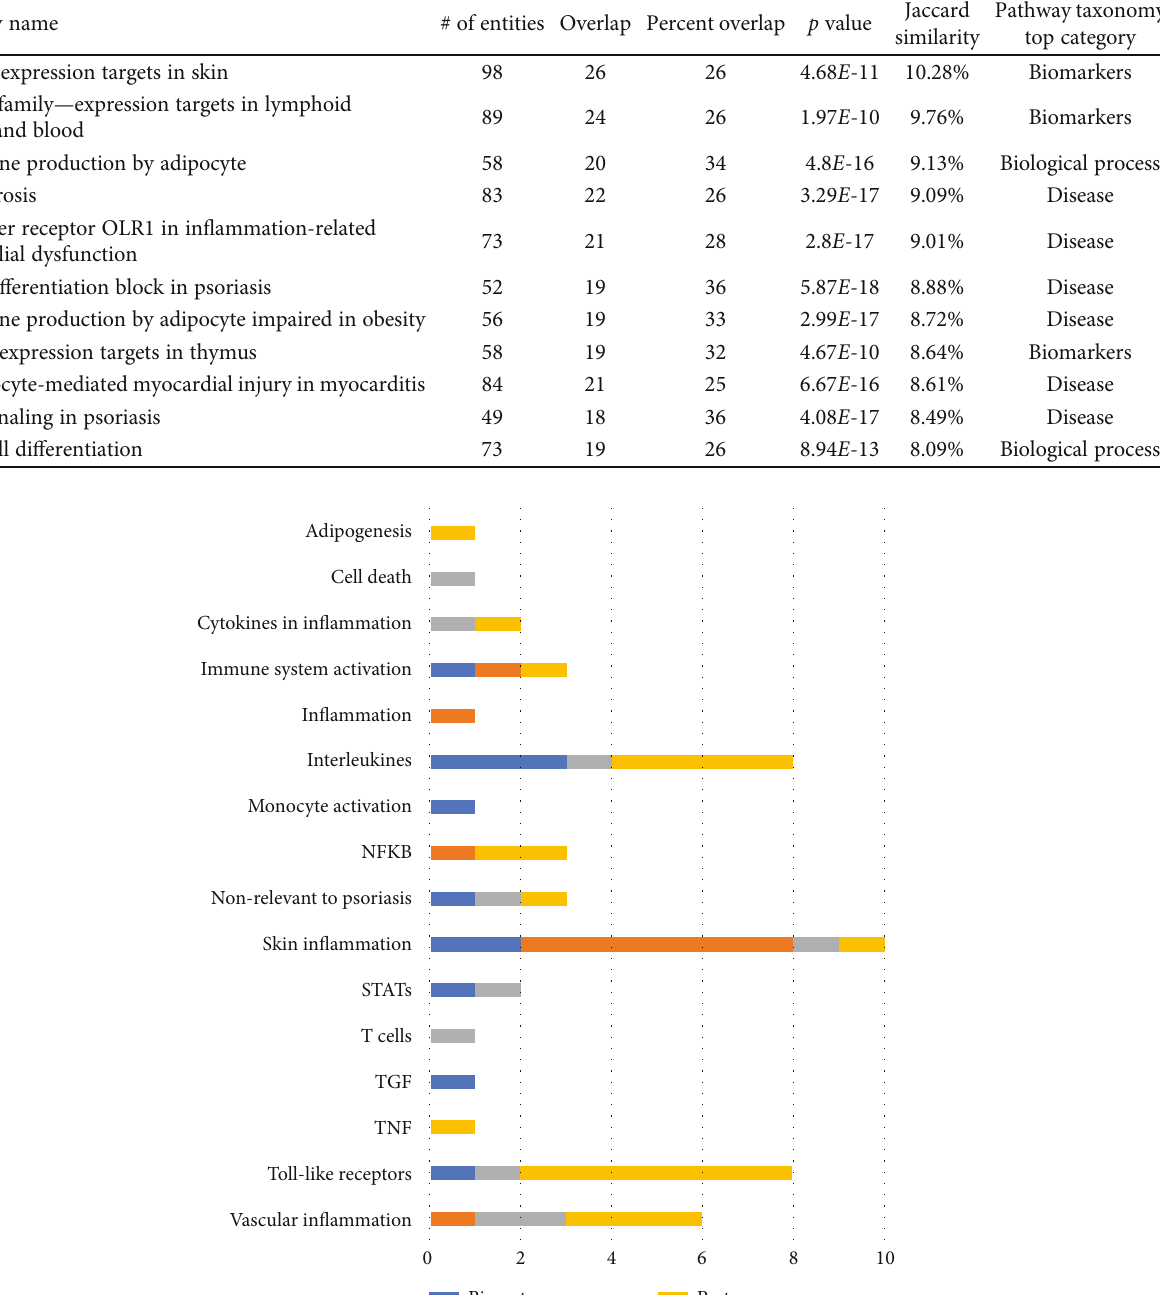
Table 2: List of PS pathways associated with members of PPAR γ -downregulated signaling associated with psoriasis. See complete results with additional statistics in supplemental materials, “ PPRAG network analysis ” fi le.